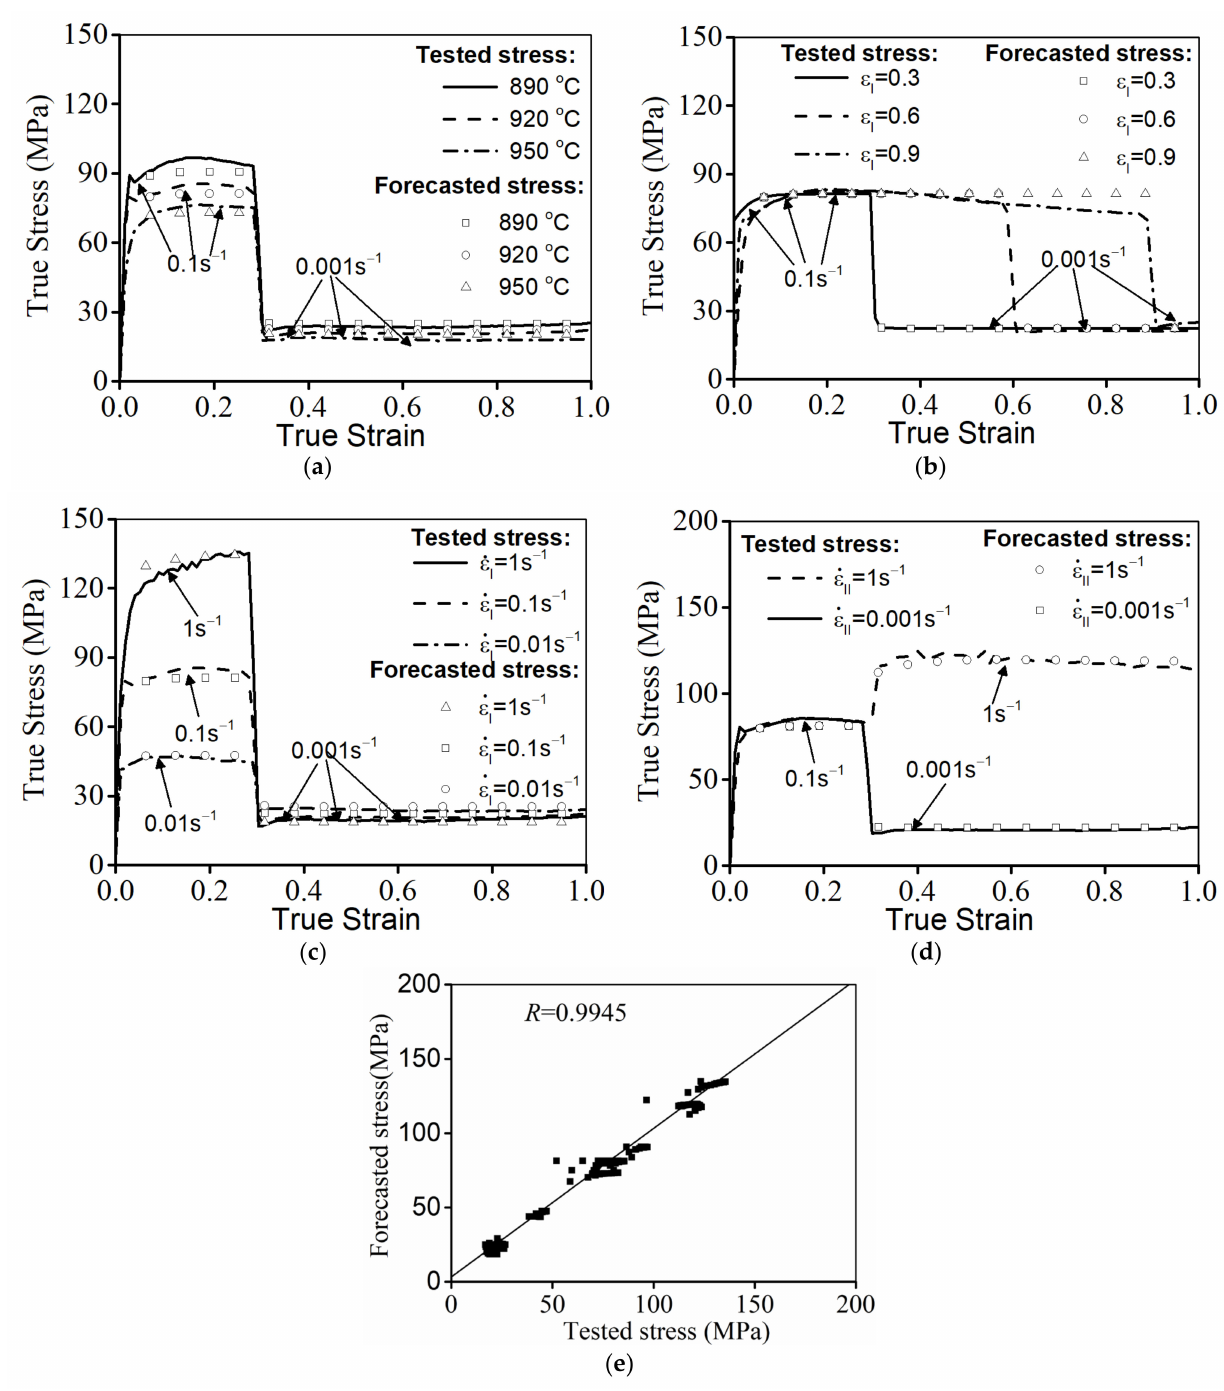
. . ε I , ( d ) ε II , ( e ) relevant